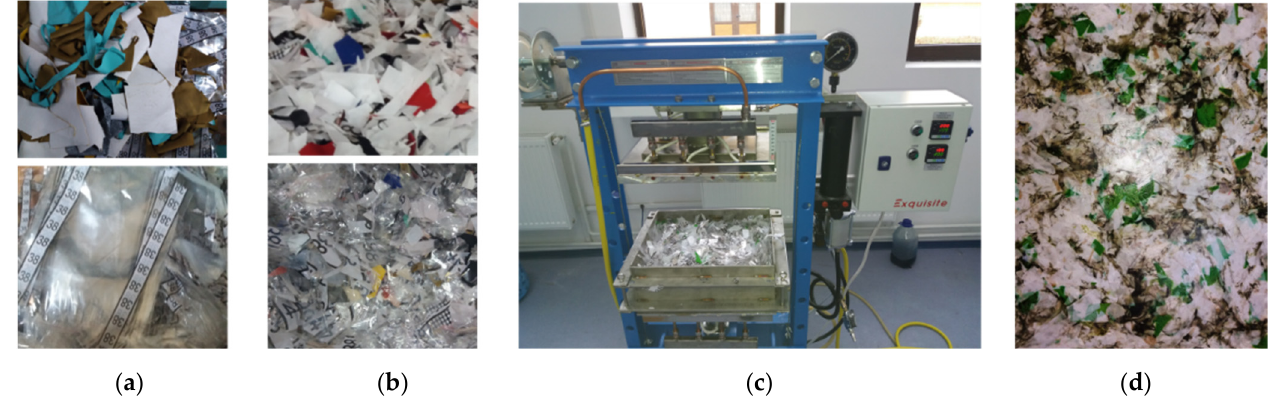
Figure 3. The stages of the technological thermoforming process: ( a ) pre-and post-production waste; ( b ) cutting; ( c ) mixing, thermoforming and cooling; ( d ) waste-based composite panel.